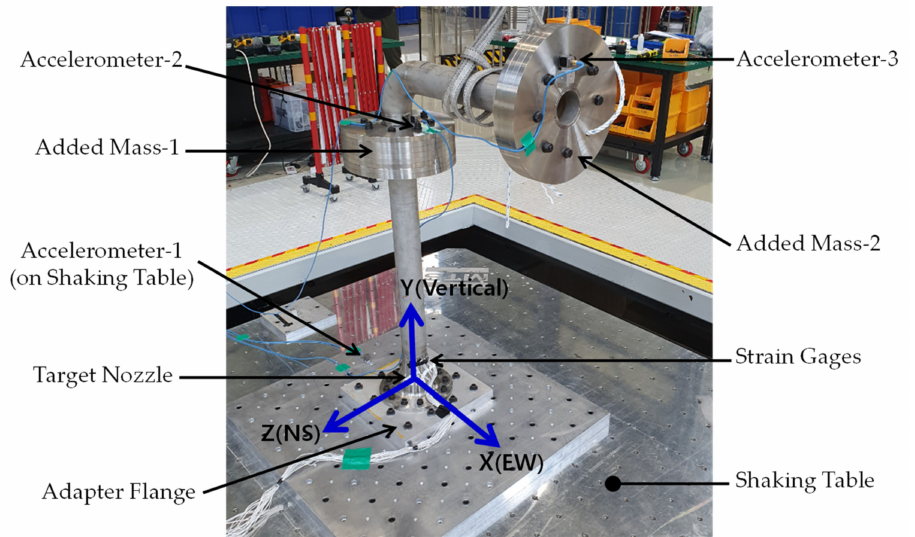
Figure 5. Photo of test mockup with sensors on the shaking table.